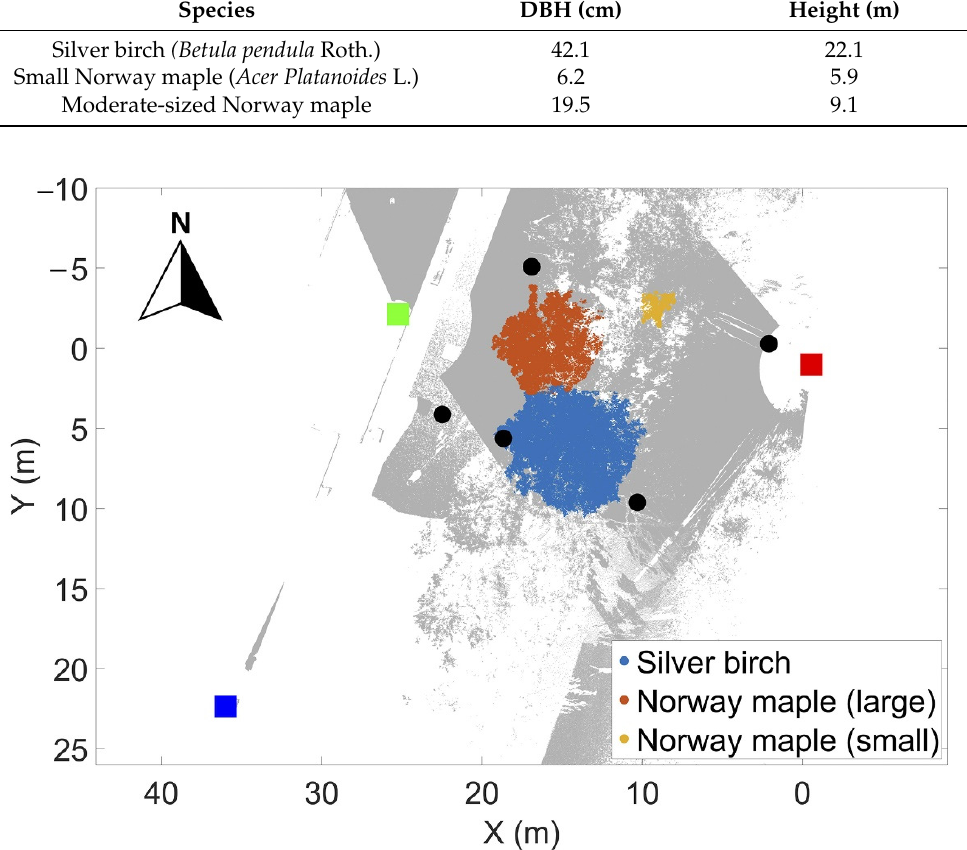
Table 1. Tree characteristics: diameter at breast height (DBH) and height for the investigated trees in the field. Species DBH (cm) Height (m) Silver birch (Betula pendula Roth.) Small Norway maple ( Acer Platanoides L.)